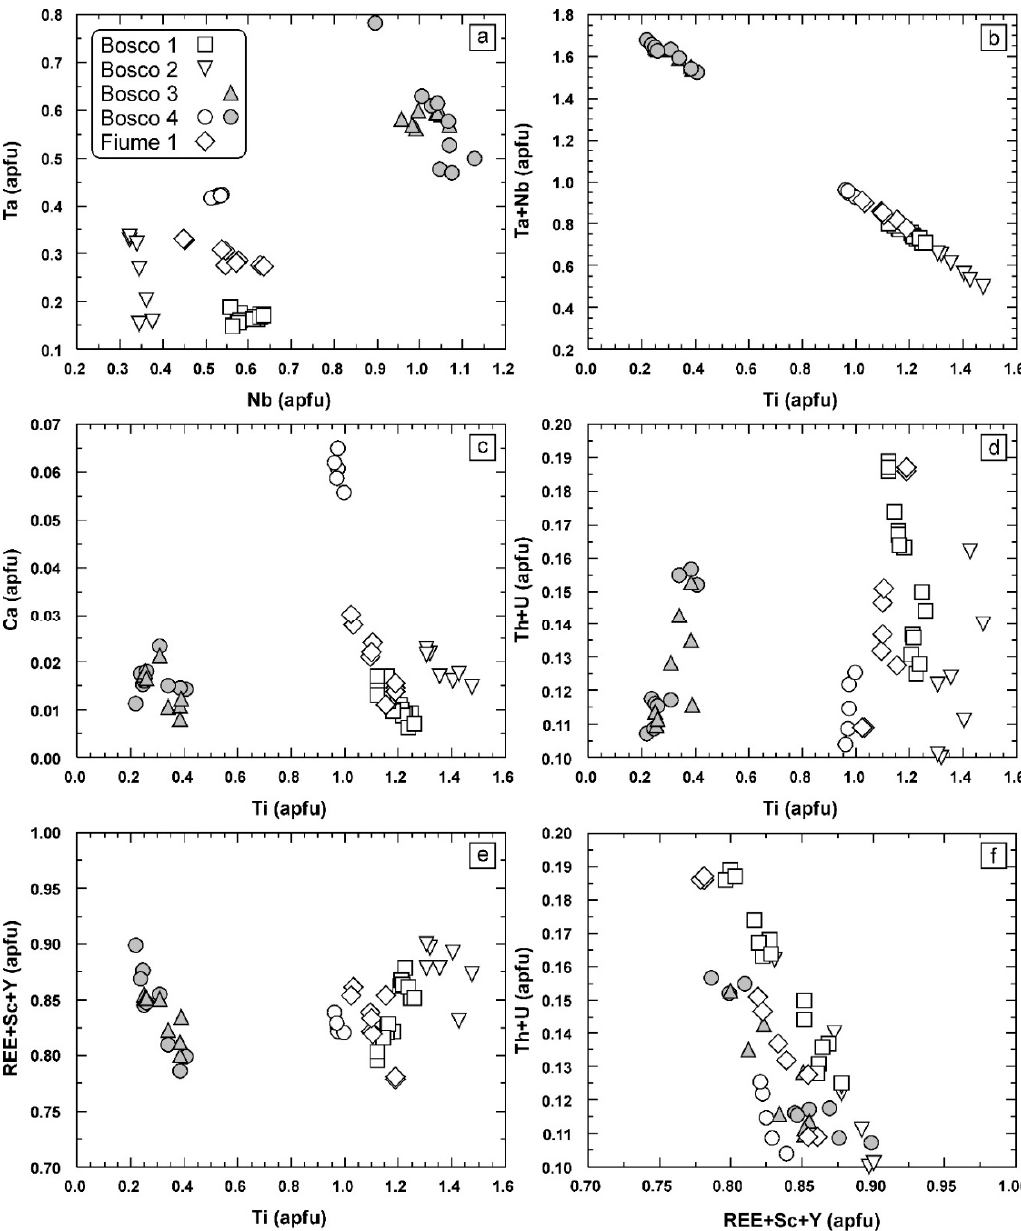
Figure 4. The quadrilateral plots showing compositional variations of aeschynite-(Y), polycrase-(Y), and samarskite-(Y) from ( a ) to ( f ). For all plots, the symbols plotted in white are aeschynite-(Y) and polycrase-(Y), and in grey samarskite-(Y).